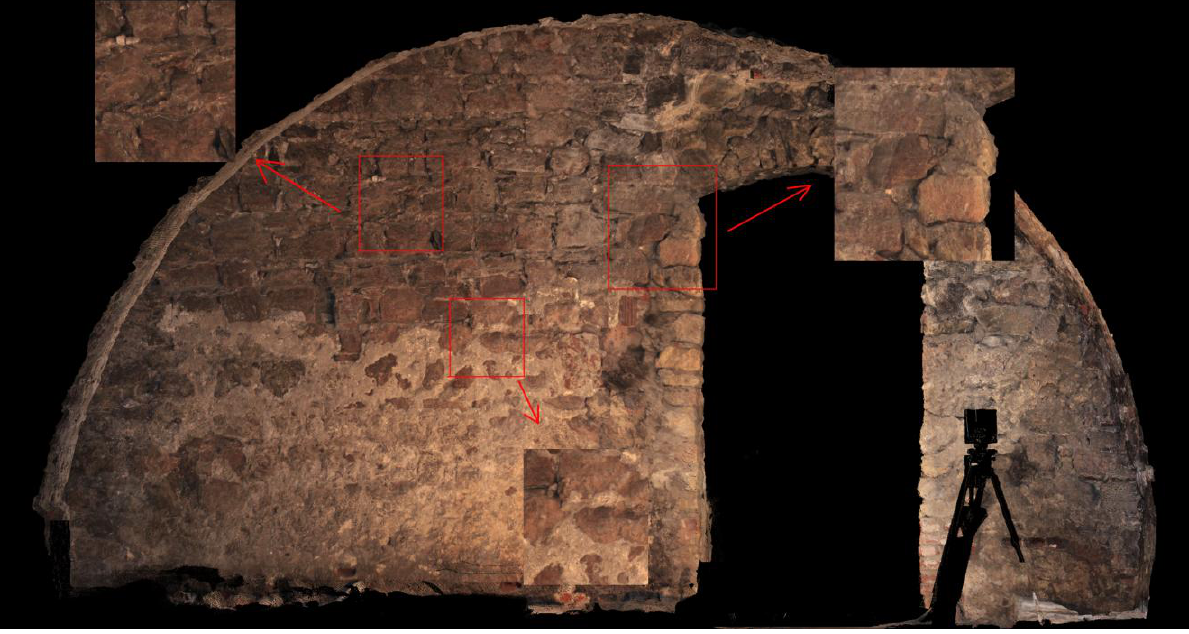
Fig. 16 RGB orthoimages with marked overlaps (Variant